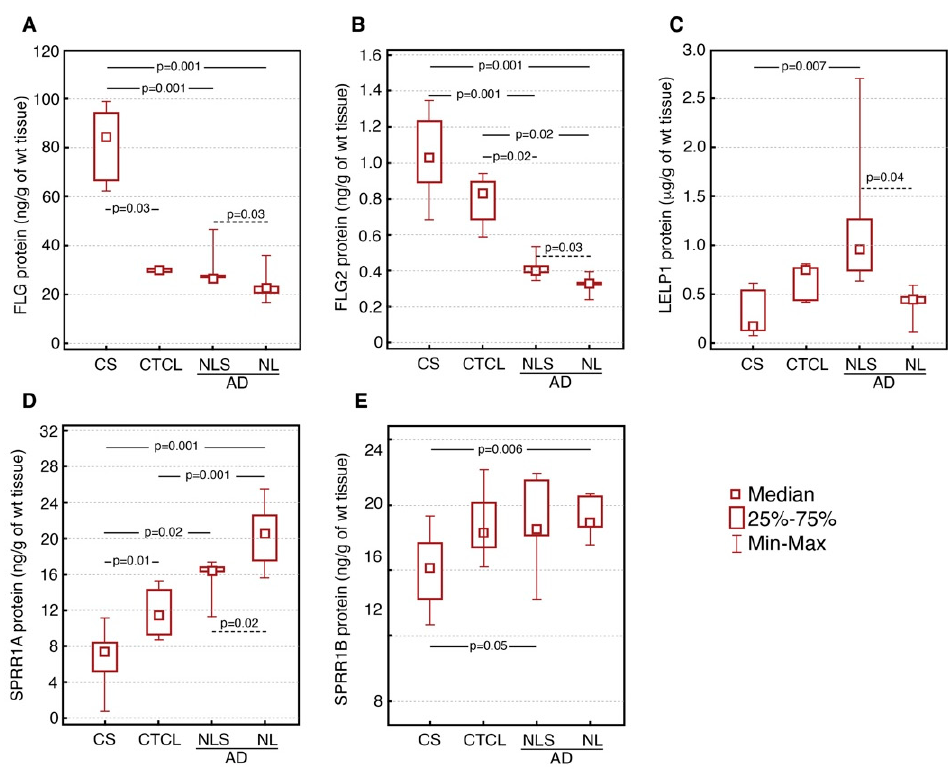
Figure 2. Levels of FLG ( A ), FLG2 ( B ), LELP1 ( C ), SPRR1A ( D ) and SPRR1B ( E ) proteins in skin of healthy subjects (CS) and patients with CTCL, lesional AD (LS AD) and nonlesional AD (NLS AD).